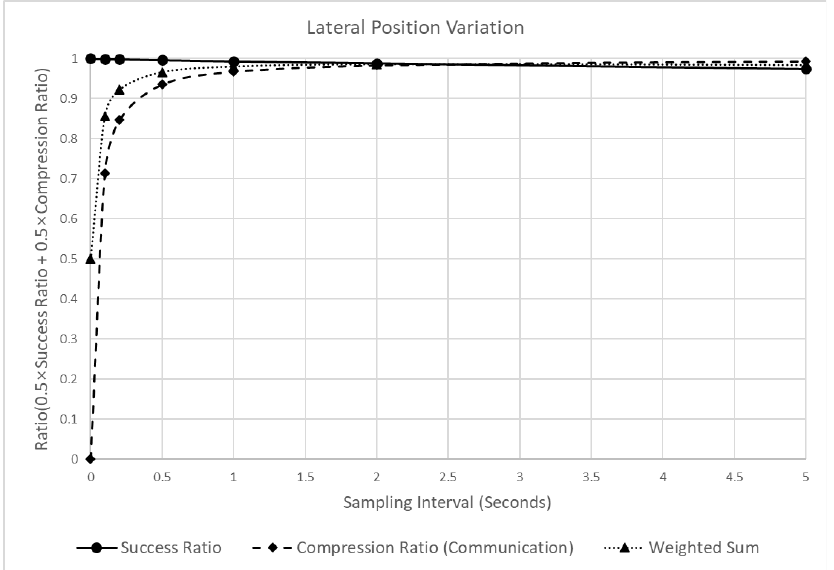
Figure 13. Analysis of the detection success ratio, compression ratio, and a weighted sum of the LPV varying the sampling intervals.